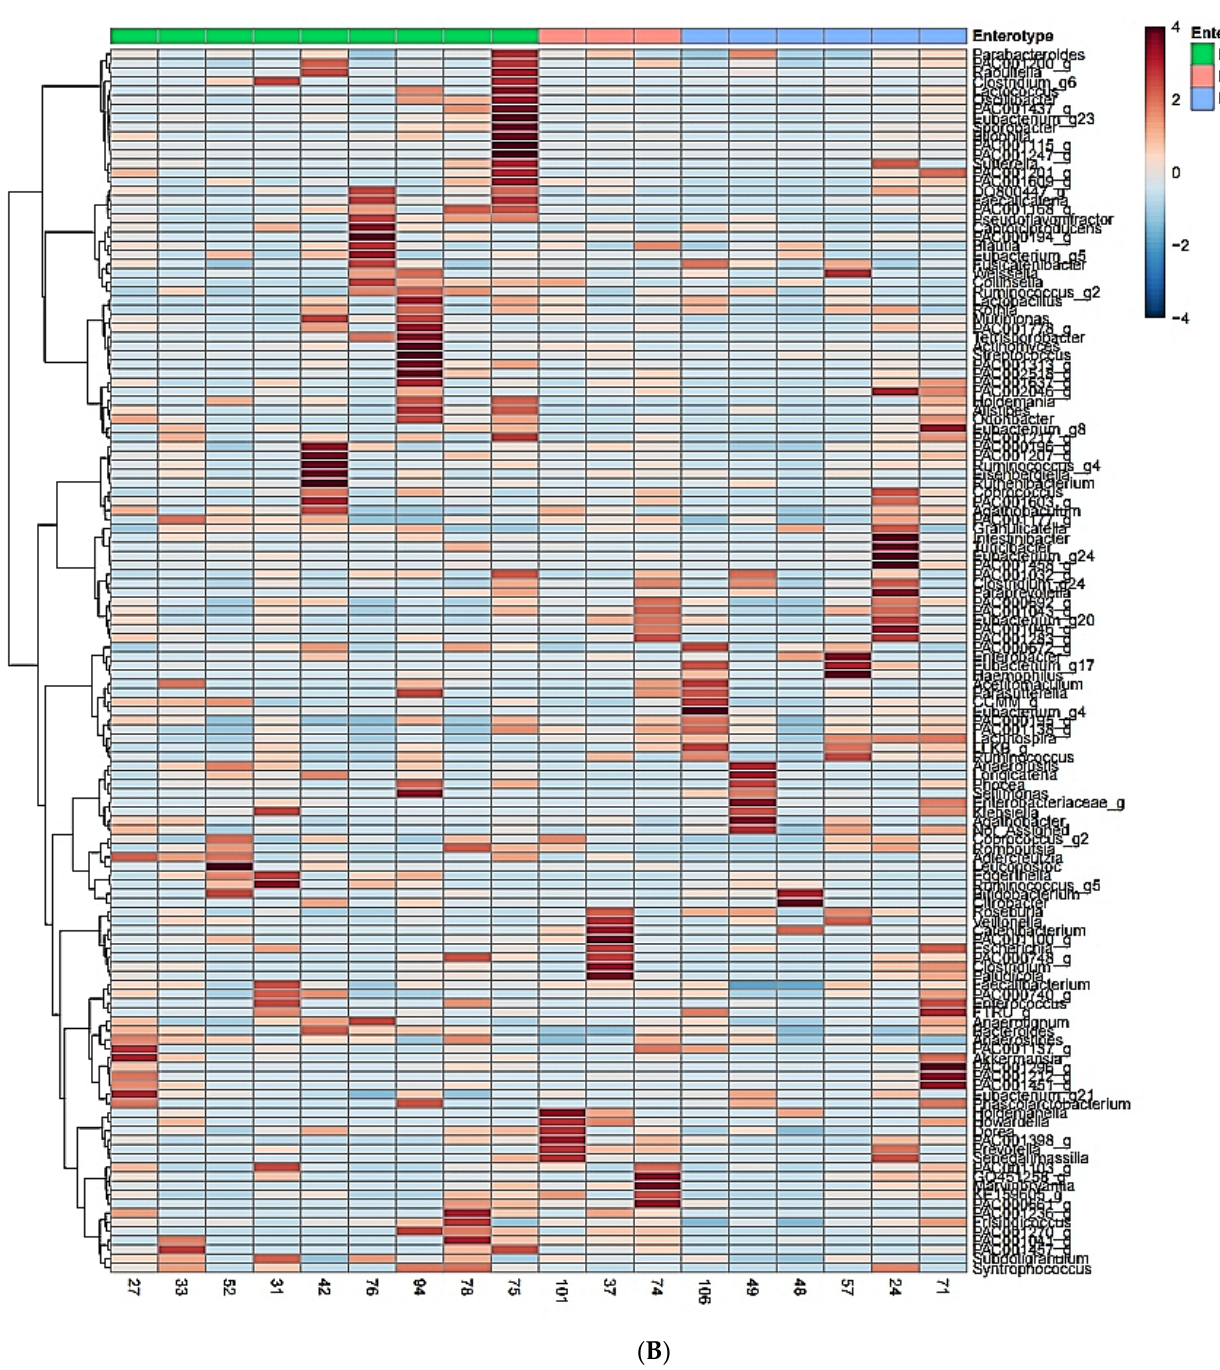
Figure 6. Heatmap clustering according to the Enterotype of all subjects. ( A ) The heatmap clustering shown by the enterotype for each timepoint of the subjects Taxonomy level is Family, and Order is stated in front of it. Distance measure was performed by Pearson, clustering algorithm was performed by Average, and cluster samples were performed according to the experimental factor Enterotype. ( B ) Heatmap clustering divided by enterotype at each after timepoint of subjects Taxonomy level is Genus, and Family is specified in front of it. Distance measure was performed by Pearson, clustering algorithm was performed by Average, and cluster samples were performed according to the experimental factor Enterotype. Distance measure is a method of applying a parameter in the clustering input and measuring the distance between data points, and Pearson analysis is characterized by clustering together features or samples with similar behavior. Clustering algorithm means to measure the distance between clusters, and average connection is a method of calculating the average of the distances between all points in the cluster when measuring the distance between two clusters.